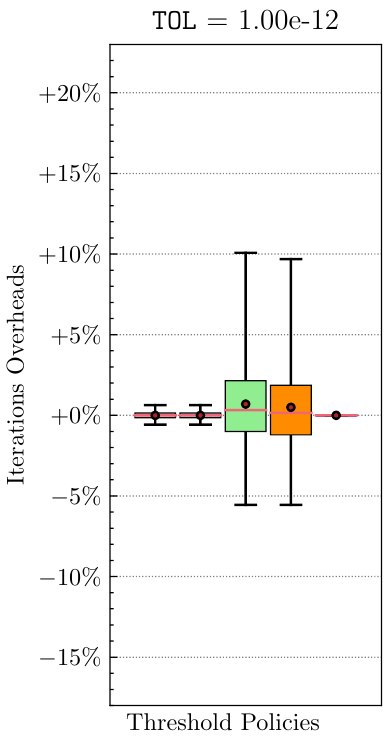
Figure 14. Total number of iterations’ overhead w.r.t each policy for TOL = 10 − 12